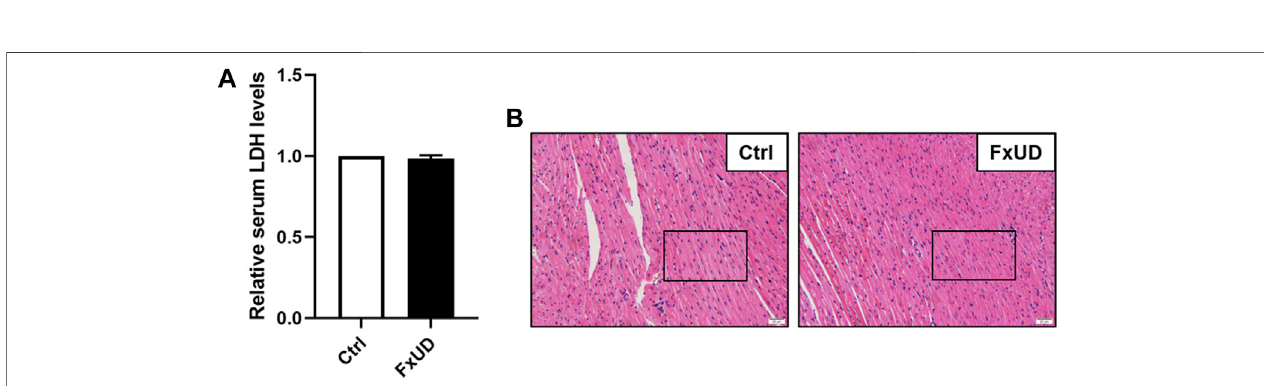
Frontiers in Pharmacology |